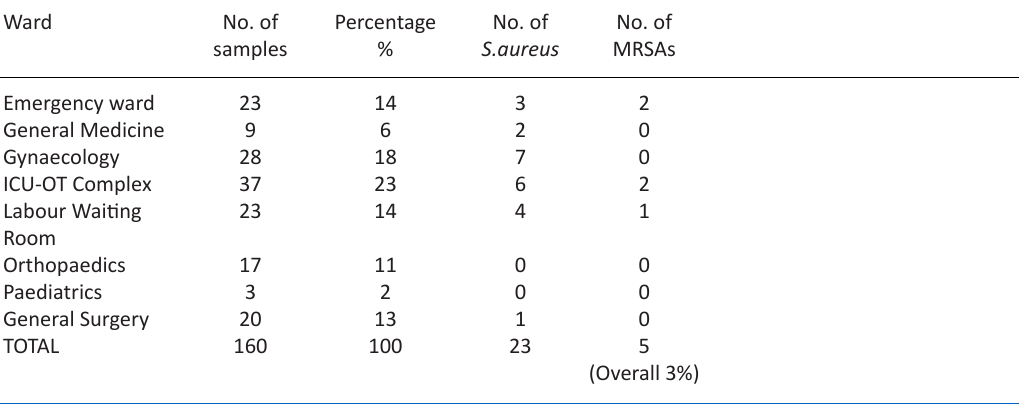
Table 1. Ward-wise No., of samples and isolates Ward No. of